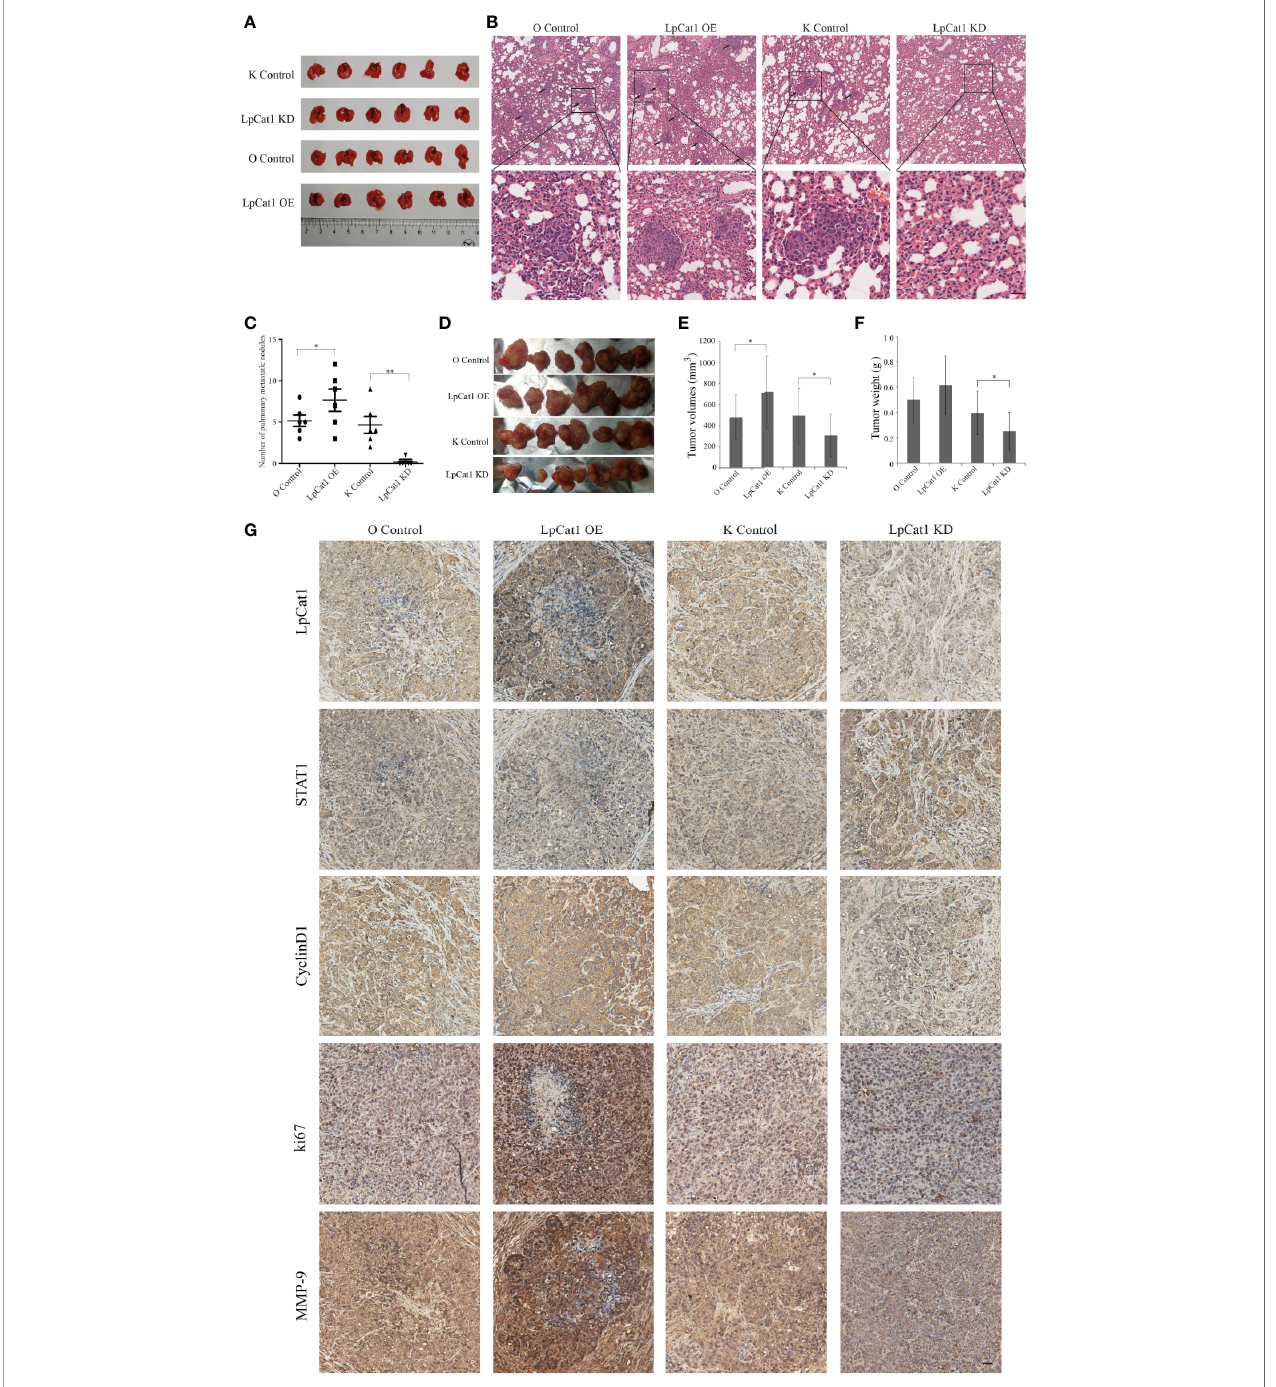
FIGURE 4 | LpCat1 promoted tumorigenesis and metastasis in vivo . (A) Hep3B cells stably transfected with different constructs were separately injected into the tail vein of nude mice to form metastasis model. The photo of lungs in each group (n = 6 mice per group) was taken. (B) HE staining showed the pulmonary metastatic nodules of nude mice (scale bar = 50 µm). (C) The numbers of metastatic nodules in the lungs of each mouse were counted and analyzed. The data were expressed as the mean ± SD, *P < 0.05, **P < 0.001. (D) Effect of LpCat1 on liver orthotopic xenograft tumor growth in nude mice. After the observation, mice were sacri fi ced and the tumors were harvested. (E, F) Tumor volume was calculated and tumor weight was weighed. The data were expressed as the mean ± SD, *P < 0.05. (G) Immunohistochemical examination of the indicated factor expression in the xenograft tumors (scale bar = 50